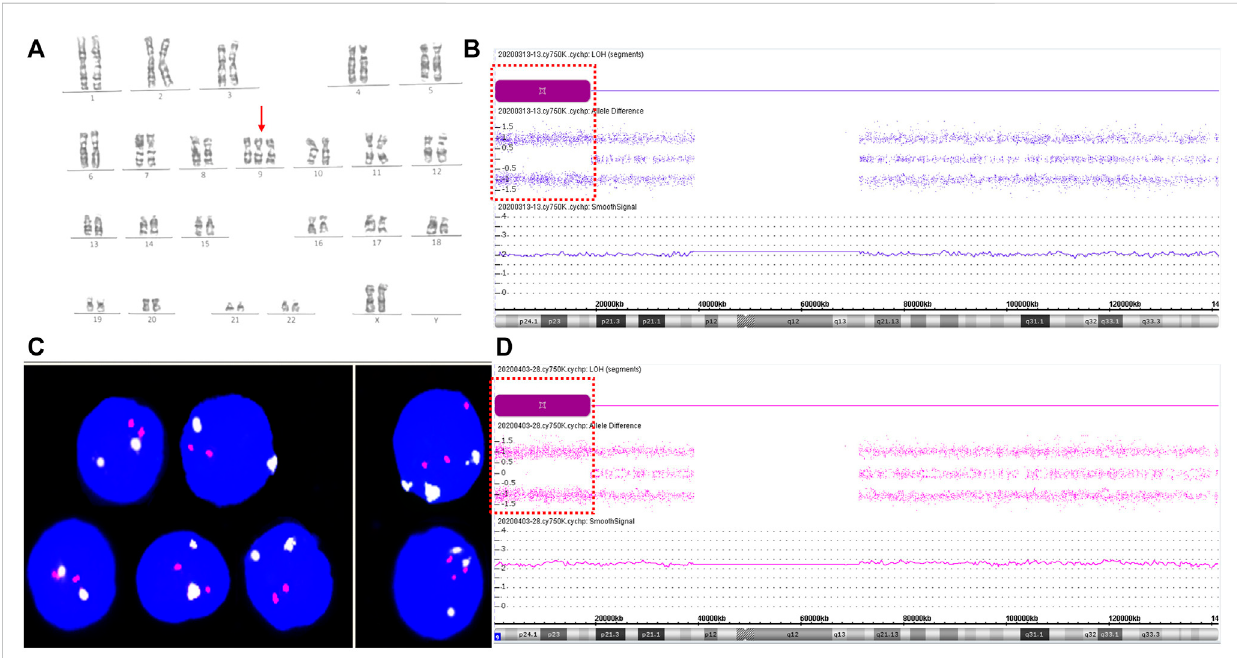
FIGURE 1 Results for trisomy 9 mosaicism in Case1. (A) Karyotype pro fi les indicating trisomy 9 (red arrows indicate the chromosome 9). (B) CMA assay results oftheuncultured amniotic fl uidsample forCase 1.Loss-of-heterozygosity(LOH)at9p24.3p22.1 detected byCMA(positions ofLOHare indicatedbythe dashed boxes). (C) FISH pro fi les of 22.4% trisomy 9 mosaicism in uncultured interphase umbilical blood cells using chromosome 9 centromere-speci fi c (white) and 9qter telomeres-speci fi c probe (red). (D) CMA assay results of uncultured umbilical blood sample for Case 1. LOH at 9p24.3p22.1 detected by CMA (positions of LOH are indicated by the dashed boxes). SmoothSignal showed 34% trisomy 9 mosaicism ( x -axis: chromosomes 9; y -axis: copy